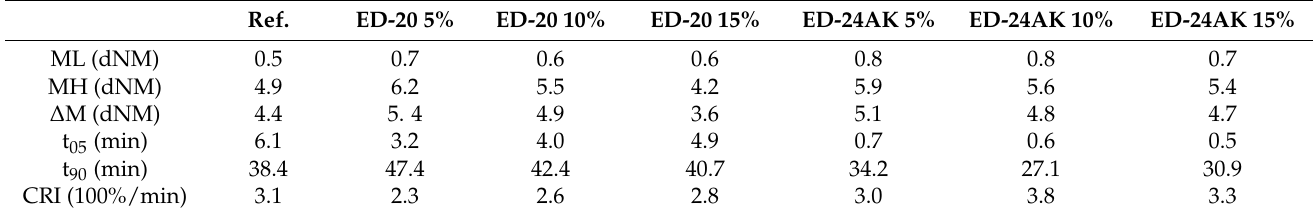
Table 2. Data collected from the vulcanization kinetics study.